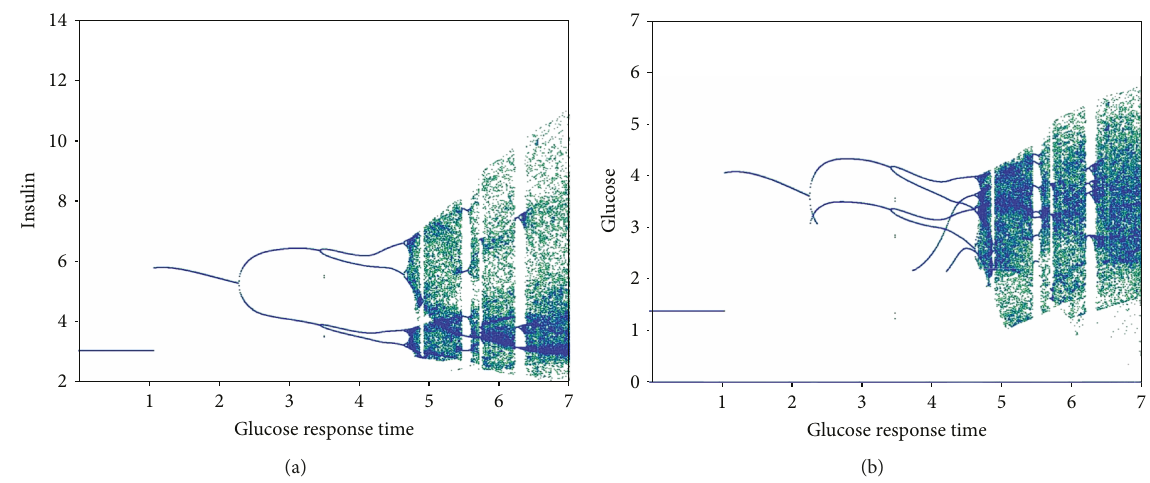
Figure 3: The model bifurcation diagrams based on di ff erent values of parameter τ